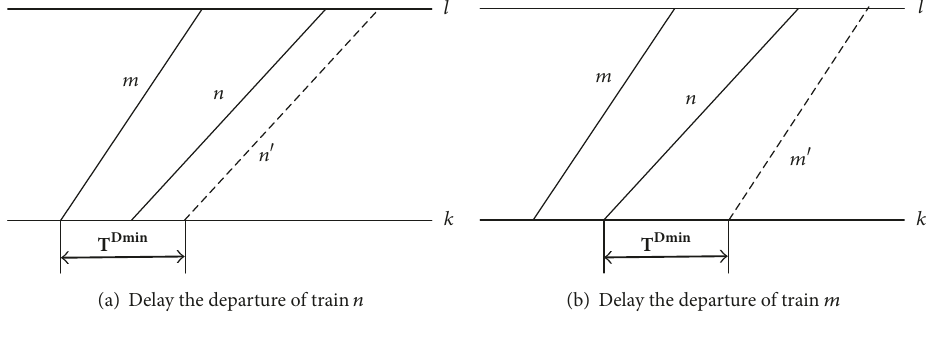
Figure 3: Departure time conflict and resolution.